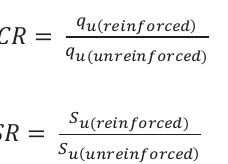
/ B at axial centric loading ( e = 0, a = f